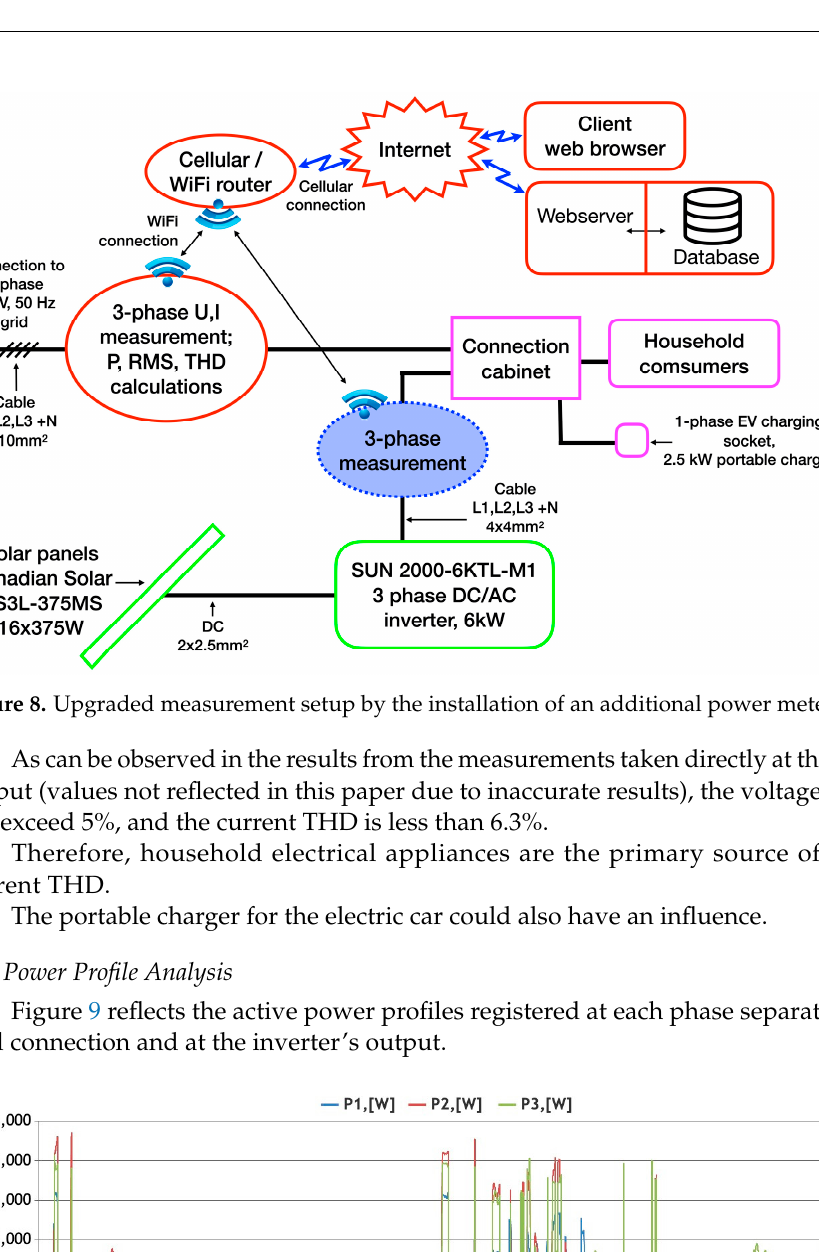
Figure 10. Calculated each phase power factor PF1, PF2, PF3 at the grid connection point. The power factor values in Figure 10 are positive or negative depending on the di- rection of energy flow. The power factor values are mainly close to 1. The exception is when the water pump’s motor periodically starts and stops, or other load transients occur, causing the power factor to drop below 1. The inverter’s output power values on all phases are negative—the energy flow is from the inverter to the household connection cabinet (Figure 8), consumers, and grid. The picture is quite different for the household connection to the grid. At this point, the grid is unbalanced: one phase (P3) consumes energy, but two other phases (P1, P2) feed energy into the grid.